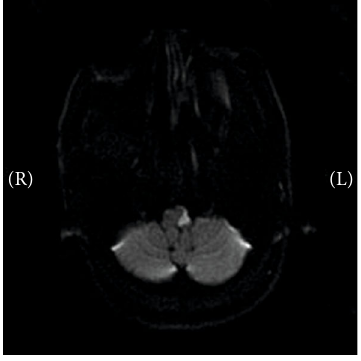
Figure 4: Medullary stroke.